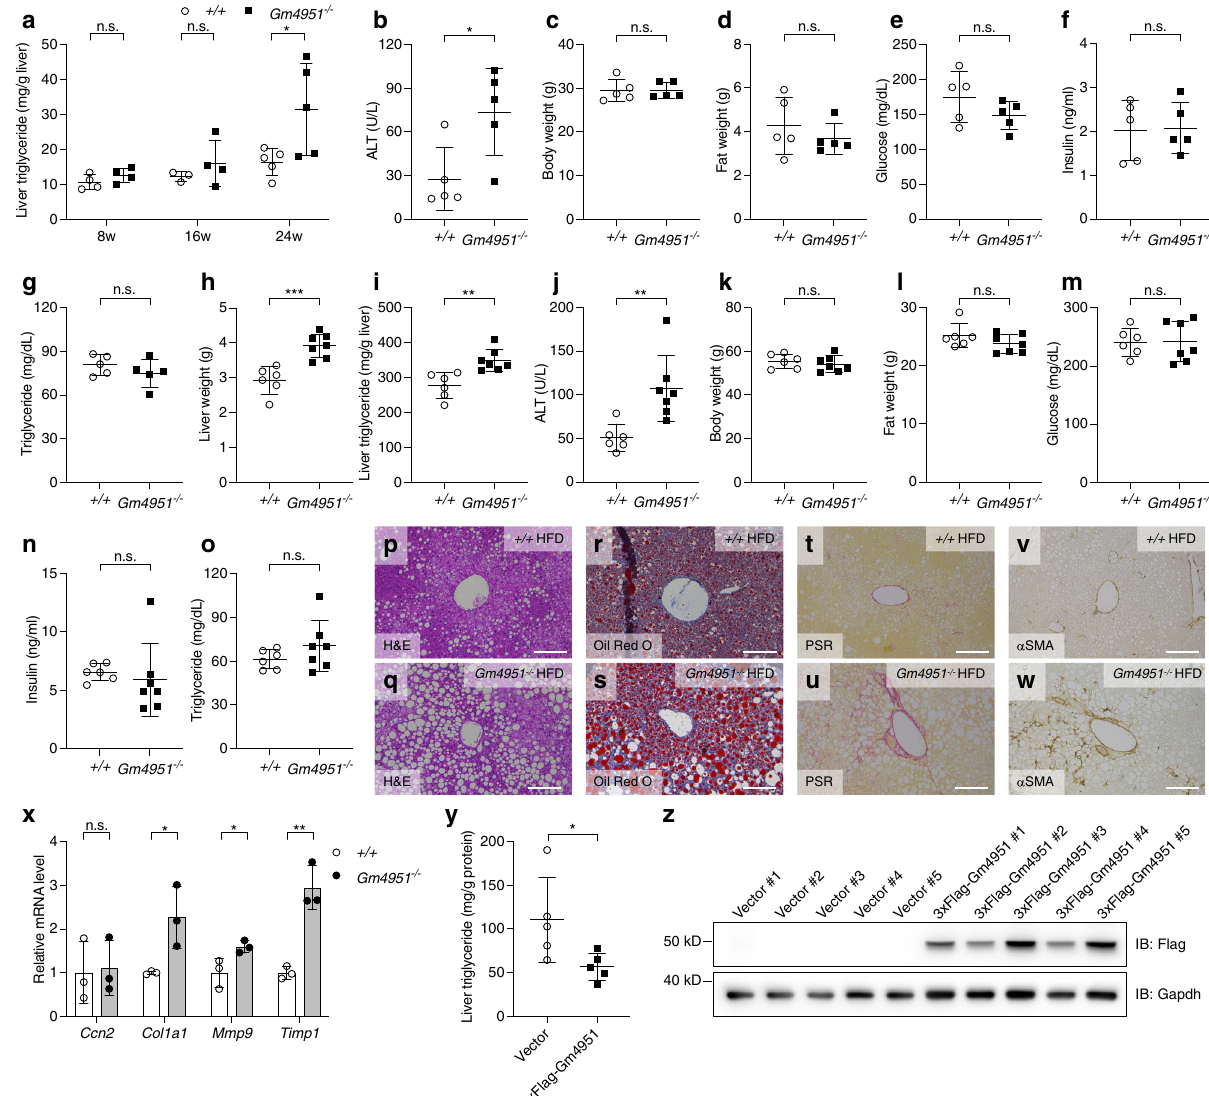
Fig. 3 The development of NAFLD in Gm4951 − / − mice on chow diet and HFD. a Liver triglycerides in WT and Gm4951 − / − mice on chow diet for eight weeks ( n = 4 in WT; n = 4 in Gm4951 − / − ), 16 weeks ( n = 3 in WT; n = 4 in Gm4951 − / − ), and 24 weeks ( n = 5 in WT; n = 5 in Gm4951 − / − ). b – g Serum ALT ( b ), body weight ( c ), fat weight ( d ), fasting glucose ( e ), fasting insulin ( f ), and fasting serum triglycerides ( g ) of WT ( n = 5) and Gm4951 − / − ( n = 5) mice on chow diet for 24 weeks. h – o Liver weight ( h ), liver triglycerides ( i ), serum ALT ( j ), body weight ( k ), fat weight ( l ), fasting glucose ( m ), fasting insulin ( n ), and fasting serum triglycerides ( o ) of WT ( n = 6) and Gm4951 − / − ( n = 7) mice on HFD for 24 weeks. p – w H&E staining ( p and q ), Oil Red O staining ( r and s ), PSR staining ( t and u ), and α SMA staining ( v and w ) of liver sections from WT and Gm4951 − / − mice on HFD for 24 weeks. (Scale bars: 100 μ m). x Relative mRNA level of different fi brosis-related genes in the liver from WT and Gm4951 − / − mice on HFD for 24 weeks ( n = 3 mice per genotype). Levels were normalized to Polr2a mRNA and then to levels in WT mice. y Overexpression of 3xFlag-Gm4951 by hydrodynamic tail vein injection. Liver triglycerides in mice injected with control vector or 3xFlag-Gm4951 vector and fed HFD for two weeks ( n = 5 mice in each group). z Immunoblot analysis of 3xFlag-Gm4951 protein expression in mouse livers two weeks after hydrodynamic tail vein injection. Each data point represents one mouse. Data are presented as means ± SD. P values were determined by two-tailed Student ’ s t test. P values are denoted by * P < 0.05; ** P < 0.01; *** P < 0.001; ns, not signi fi cant with P > 0.05. The exact P values of statistically signi fi cant groups are: 0.0177 ( a , 24w); 0.0234 ( b ); 0.0005 ( h ); 0.0026 ( i ); 0.0055 ( j ); 0.0355 ( x , Col1a1 ); 0.0466 ( x , Mmp9 ); 0.0031 ( x , Timp1 ); 0.0463 ( y ). Data are representative of two independent experiments ( a – o , x – z ) or from one experiment ( p – w ).